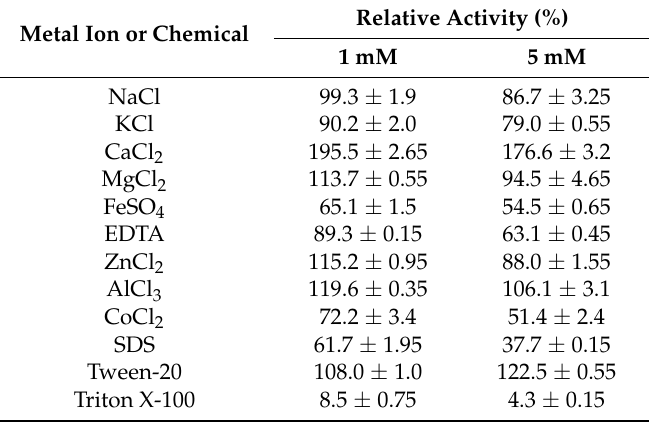
Table 3. Effect of metal ions and chemical reagents on the enzyme activity of PpPel10a. Metal Ion or